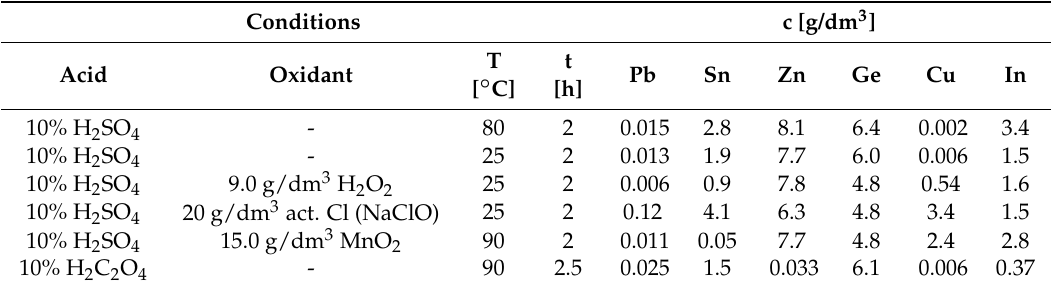
Table 2. Concentration of investigated elements in filtrates under selected process conditions (S/L = 1/10 in all cases).